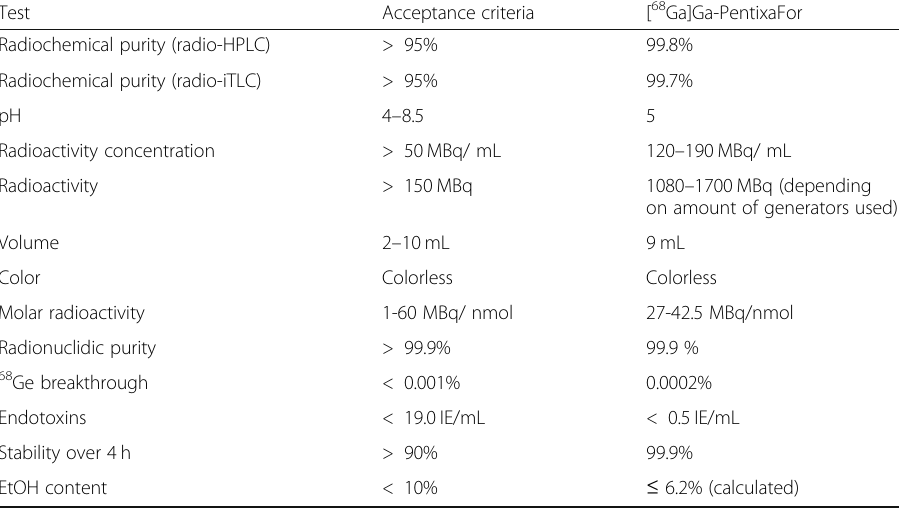
Table 2 Summary of the product specifications for 50 μ g PentixaFor, n ≥